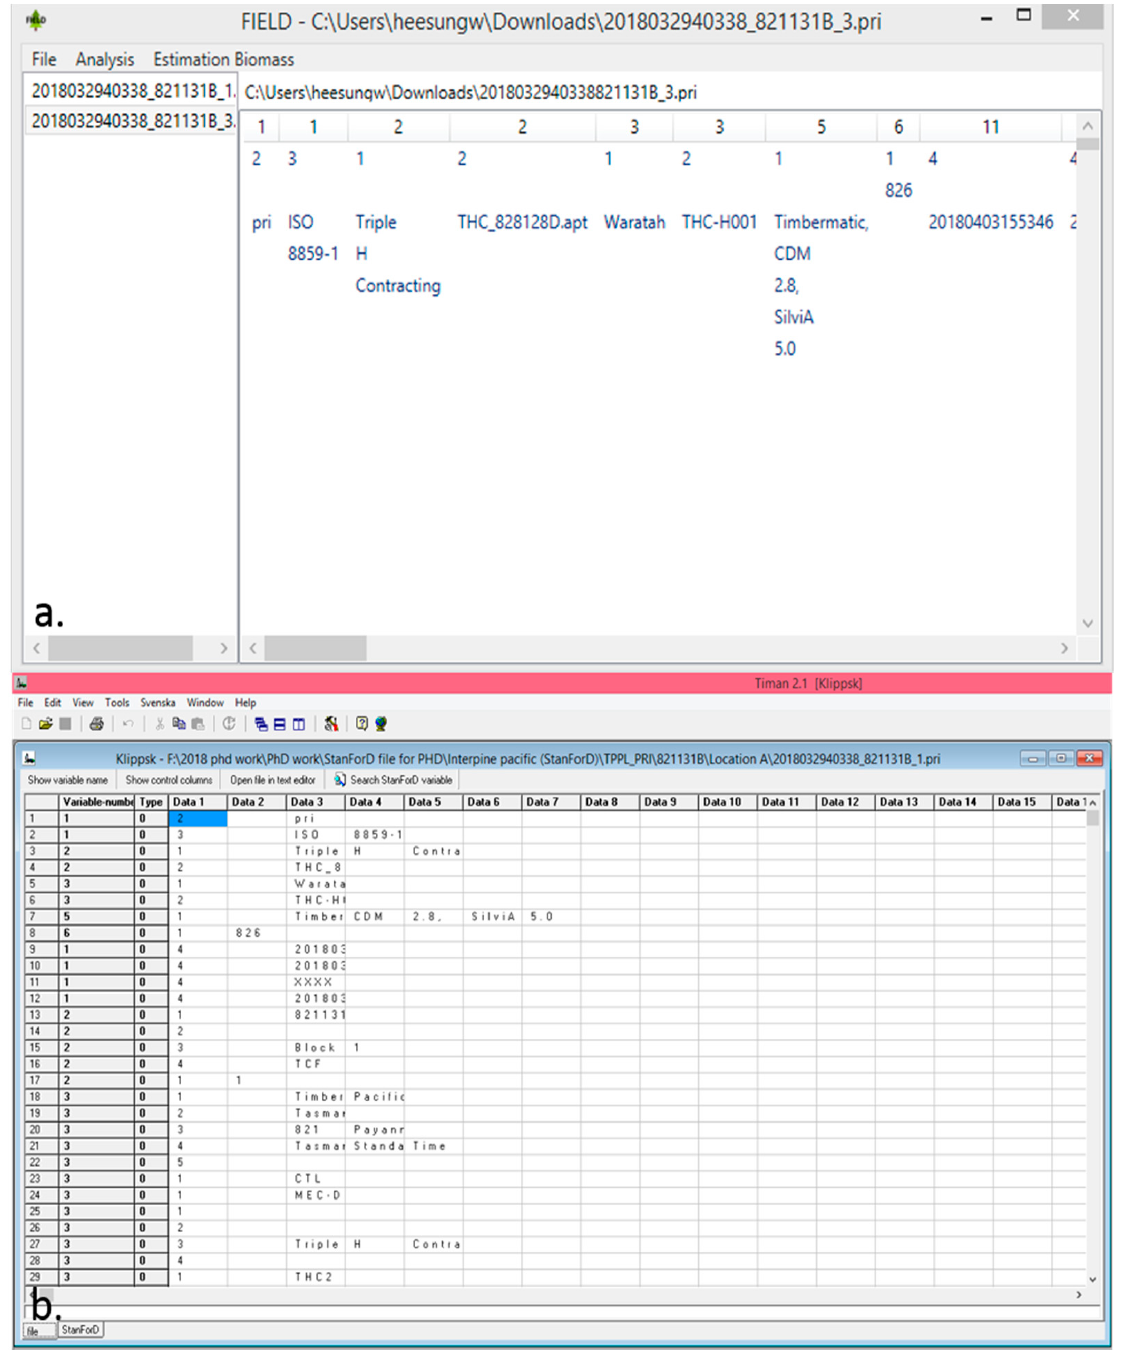
Figure 5. FIELD software validation compared to Timan 2.1 commercial software (( a ) pri file open with FIELD software, ( b ) pri file open with Timan 2.1 commercial software).